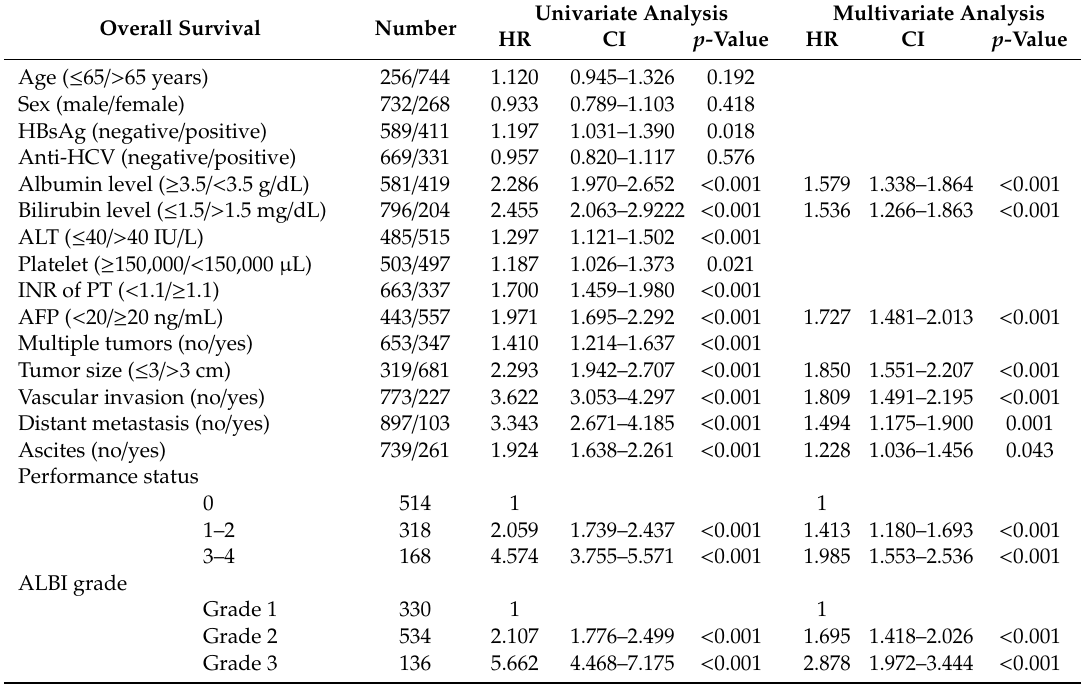
Abbreviations: AFP, α -fetoprotein; ALBI, albumin-bilirubin; ALT, alanine aminotransferase; anti-HCV, antibody against hepatitis C virus; HBsAg, hepatitis B virus surface antigen; INR of PT, international normalized ratio